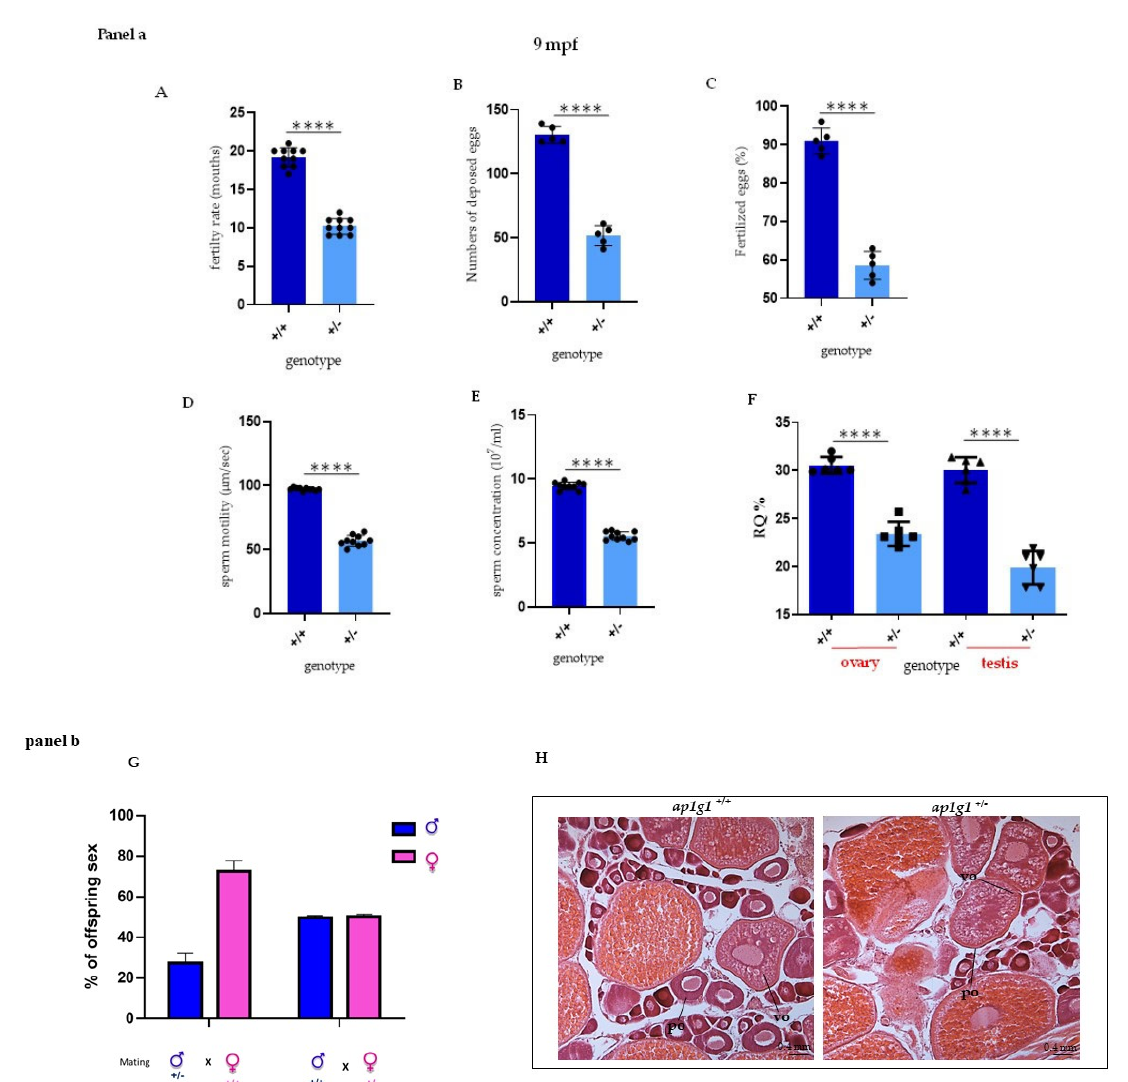
Figure 3. Fertility analysis in heterozygous ap1g1 +/ − fish. Panel a ( A ) The graph represents the fertility rate of heterozygous compared to +/+ females. The data are representative of five differ- ent experiments with 10 fish per group ( B , C ) The graphs show respectively the number of laid eggs and fertilized eggs in +/+ and +/ − females at 9-mouths-old fish obtained by three differ- ent experiments; the observed female was 12 for each group. Concentration ( D ), velocity ( E ) and viability ( F ) of ejaculated sperm. Depicted is mean ± SEM. **** p < 0.0001; n = 10, in trip- licate. Motility ( D ) and concentration ( E ) of ejaculated sperm from 1-year-old fish. Experiment was done twice. Motility: n = 10 +/+ mean = 97.20 and n = 10 +/ − mean = 56.80; concentration: n = 7 +/+ mean = 9.46 × 10 7 /mL and n = 7 +/ − mean = 5.54 × 10 7 /mL. ( F ) qPCR analysis on +/+ and +/ − fish respectively in ovary and testis. The experiment was repeated twice. n = 10 for each column. Panel b ( G ) The graph represents the percentage of different offspring obtained by matings between ap1g1 +/ − male and a p1g1 +/+ female and ap1g1 +/+ male with ap1g1 +/ − female. ( H ) Histological analysis of ap1g 1 +/+ and ap1g1 +/ − ovary detects oocyte maturation defects in mutant females; black arrowheads indicate debris of atretic follicles. Abbreviations: po primary oocyte, vo vitellogenic